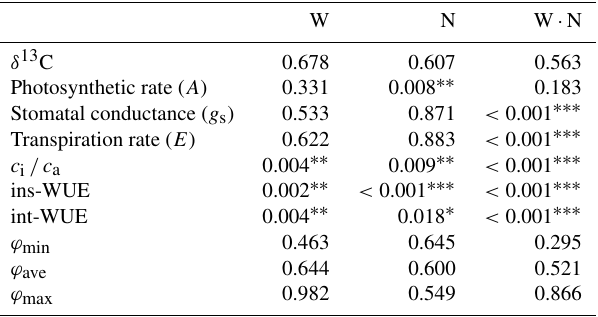
Table 1. The p values of all measured and calculated indexes in plants under two-way ANOVA analysis of water (W) and nitrogen (N) additions.